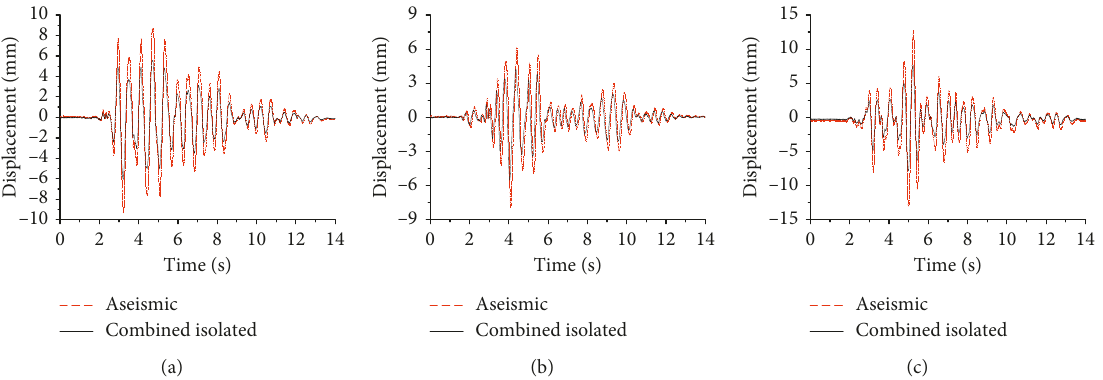
Figure 9: X -axis relative displacement time history curves of the third floor of main frame. (a) Chi-Chi-2N, (b) Chi-Chi-2F, and (c) Chi- Chi-3N.